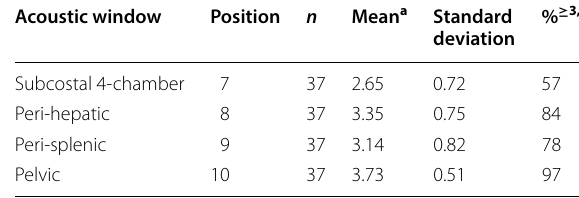
for telementored ultrasound in four different thoraco- abdominal windows (FAST)